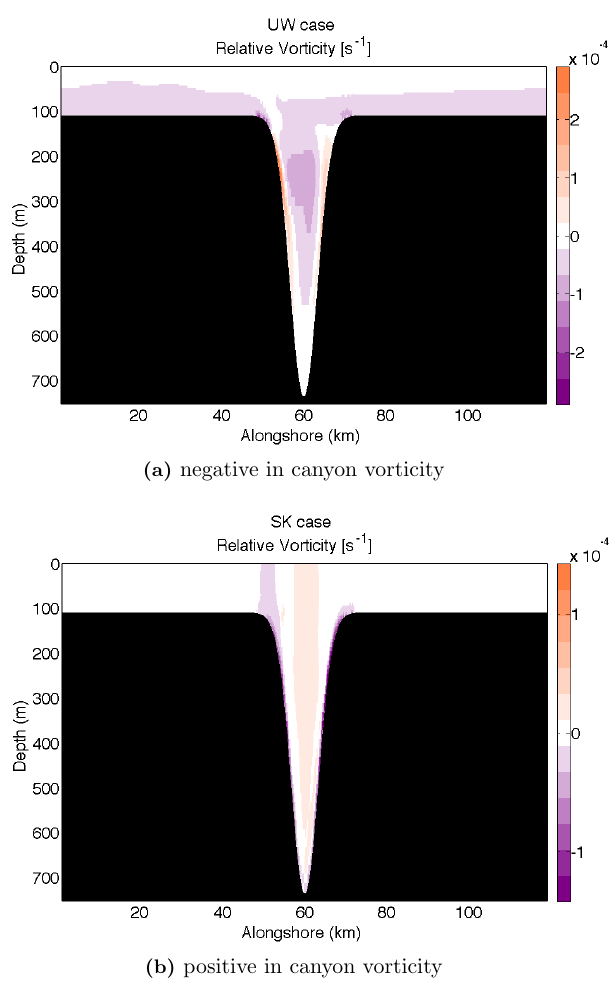
Figure 7. Cross section of vorticity at mid-canyon in (a) a simu- lation exhibiting negative vorticity (UW) and (b) a simulation ex- hibiting positive vorticity (SK). Values are averaged over a period of 3 model days during the advection phase (model days